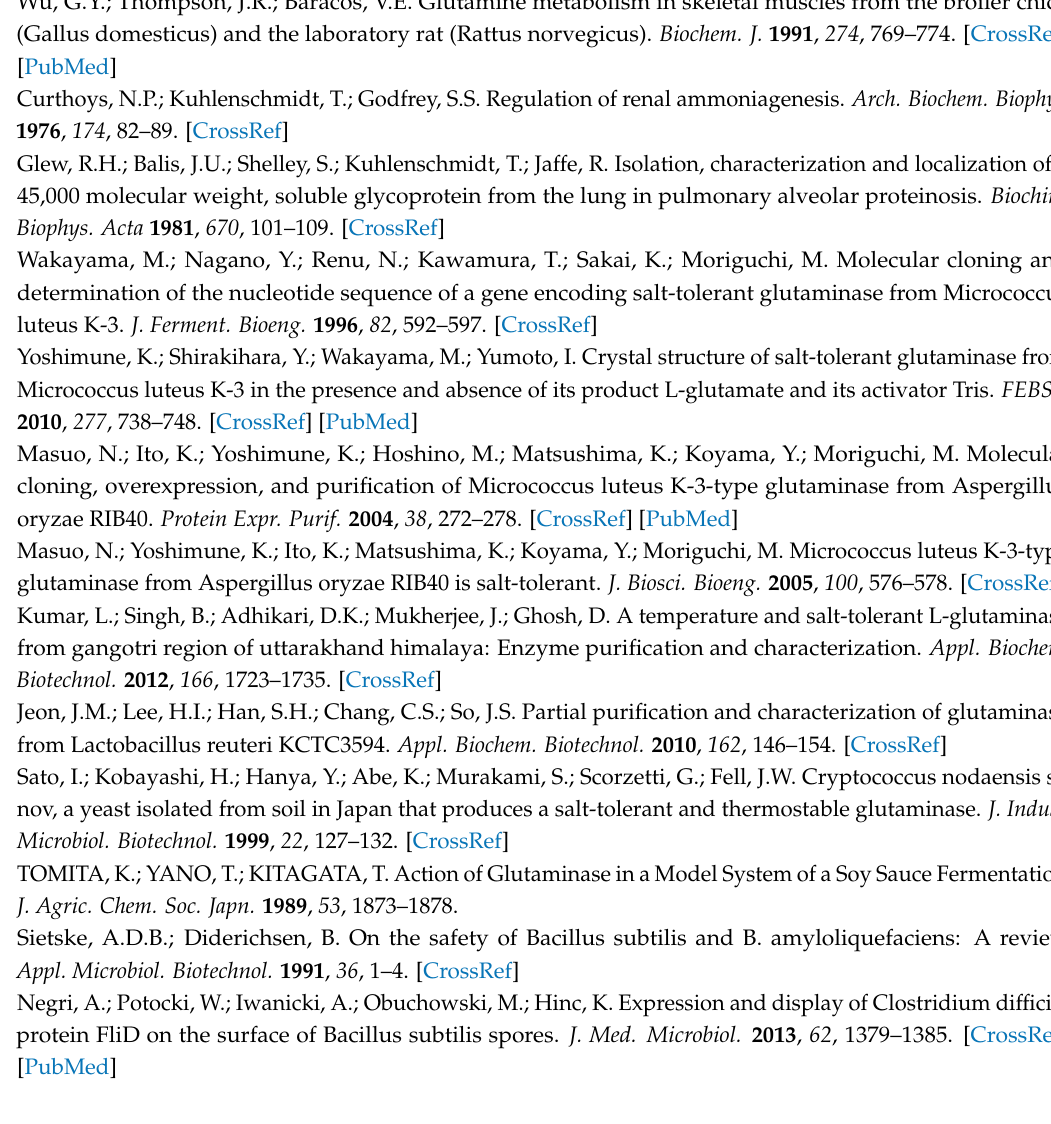
Supplementary Materials: Supplementary materials are available online. Figure S1. The result of the codon optimization of salt-tolerant glutaminase from Micrococcus luteus K-3 according to the preference of Bacillus subtilis . Figure S2. HPLC analysis of L -glutamine and L -glutamic acid. Table S1. Bacterial strains, plasmids and primers used in this study. Table S2. Glutamate analysis in the reaction mixture via HPLC and biosensor analyzer